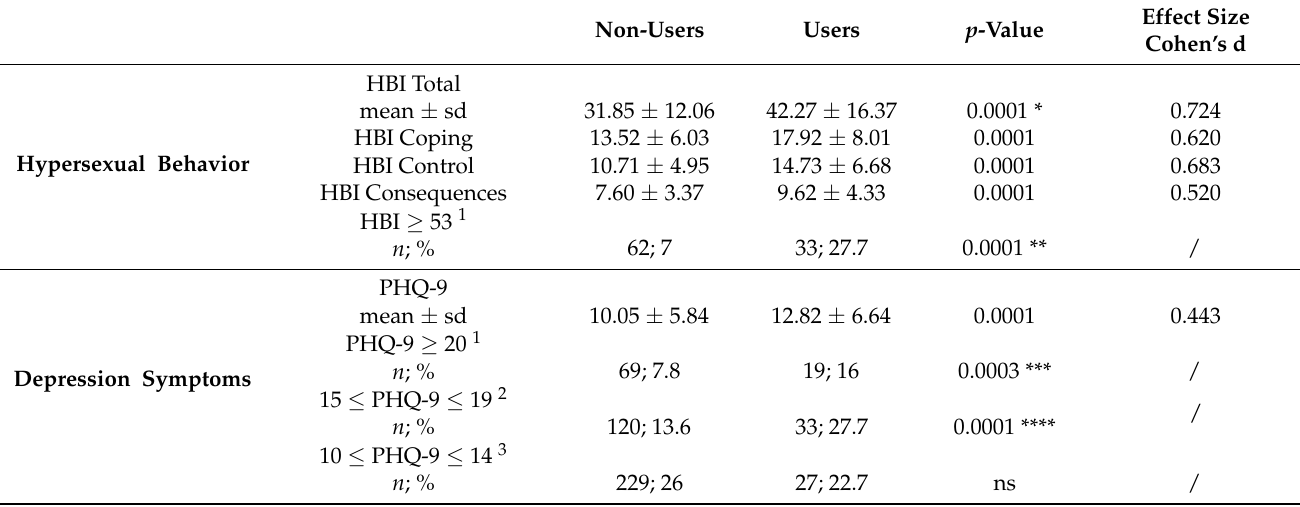
Table 3. Hypersexual Behavior and Depression Symptoms in DA users and non-users.